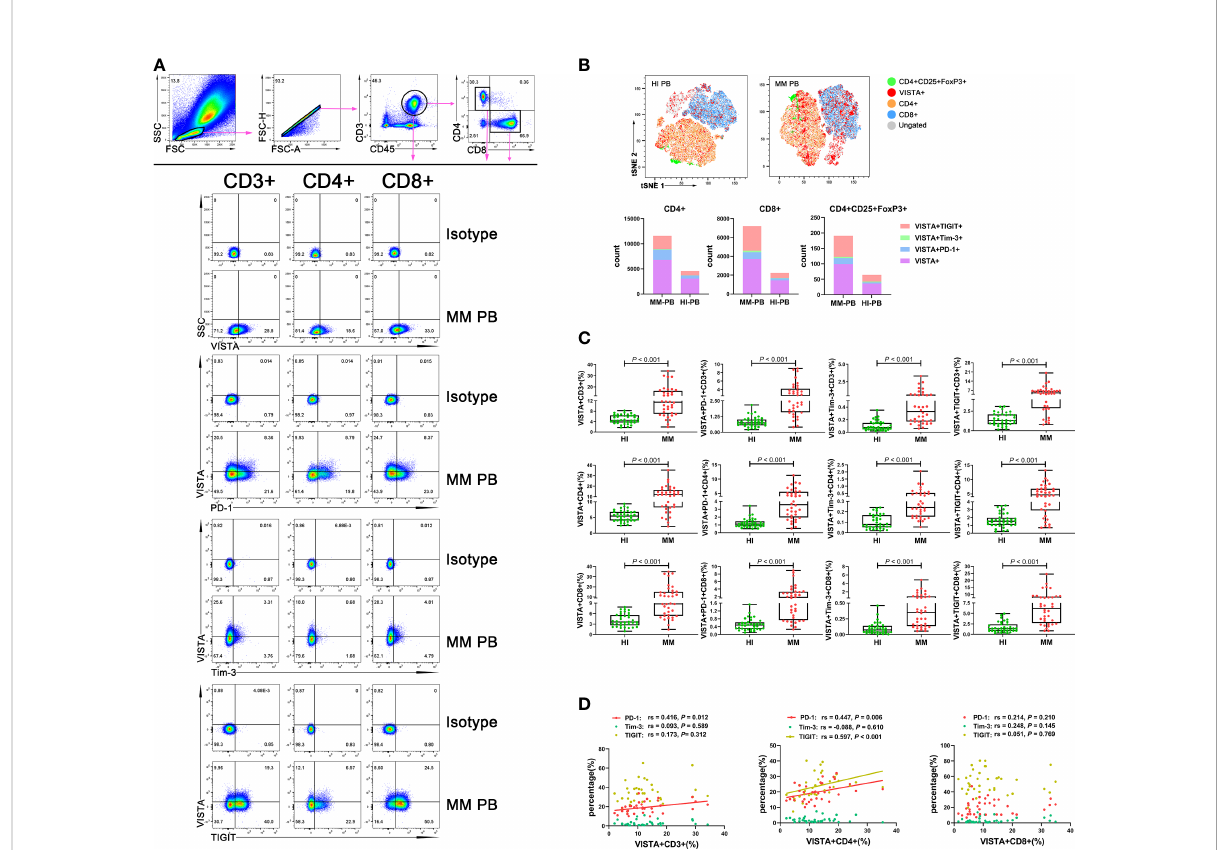
FIGURE 1 Distribution and frequency of VISTA expression and co-expression with PD-1, Tim-3, and TIGIT on T cell subsets in PB from MM patients. (A) Detection of VISTA, PD-1, Tim-3, and TIGIT expression on CD3+, CD4+, and CD8+ T cell subsets in a patient with MM. (B) tSNE clusters of the global distribution and frequency of different phenotypes of T cells in patients with MM and healthy individuals. (C) Comparison of the frequency of VISTA expression and co-expression with PD-1, Tim-3, and TIGIT on CD3+, CD4+, and CD8+ T cell subsets in patients with MM and healthy individuals. (D) Correlation between the percentages of VISTA+ and PD-1+, Tim-3+ and TIGIT+ T cells in T cell subsets in MM